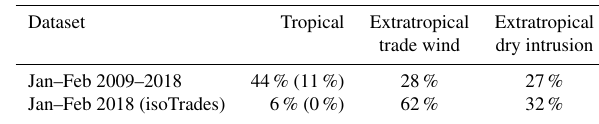
Table 1. Occurrence frequency of the three flow regimes defined in this study based on a classification of all hourly time steps in January–February in the period 2009 to 2018. The tropical flow regime is defined with ˜ τ 35 < 1d. This regime also includes air parcels that descend from the subtropics. The share of purely trop- ical air parcels with ˜ τ 23 . 5 < 1d is shown in parentheses. The ex- tratropical trade wind regime is defined with ˜ τ 35 ≥ 1d and a lim- ited subsidence in the last 4d prior to arrival in Barbados ( < 100hPa(4d) − 1 ) as well as extratropical dry intrusions with a res- idence time of at least 1d in the extratropics and enhanced subsi- dence ( ≥ 100hPa(4d) − 1